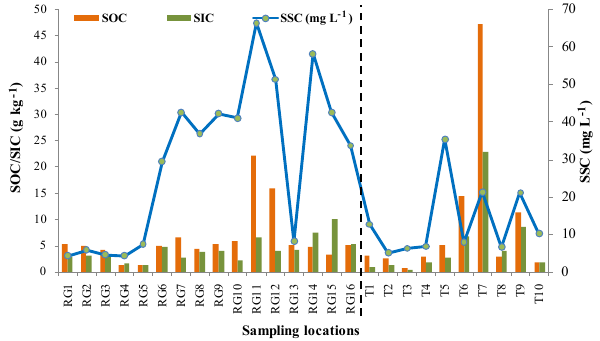
Figure 7. Correlation between SOC and SIC with